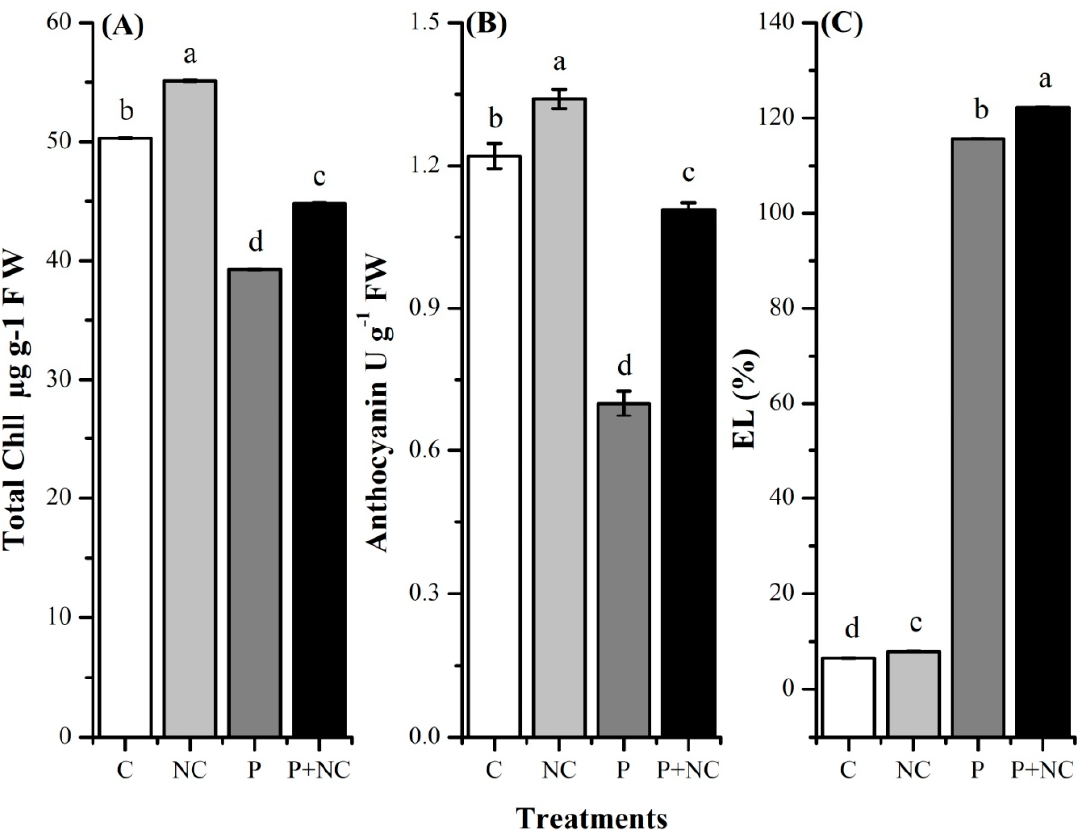
Figure 3. Different physiological parameters of plant after treatments. Total Chll ( A ), Anthocyanin ( B ), and electrolyte leakage (EL) ( C ). Different lower-case letters indicate significant difference ( p ≤ 0.01) among the different treatments. Error bars indicate ± standard error of the mean of three replicates. Note: C for control, NC = plants treated with nano-fertilizer with Ag/CHI NC, P = plants treated with R. solani , (P + NC) = pots inoculated with R. solani and Ag/CHI NC solution (50 mL) twice a day for three days.